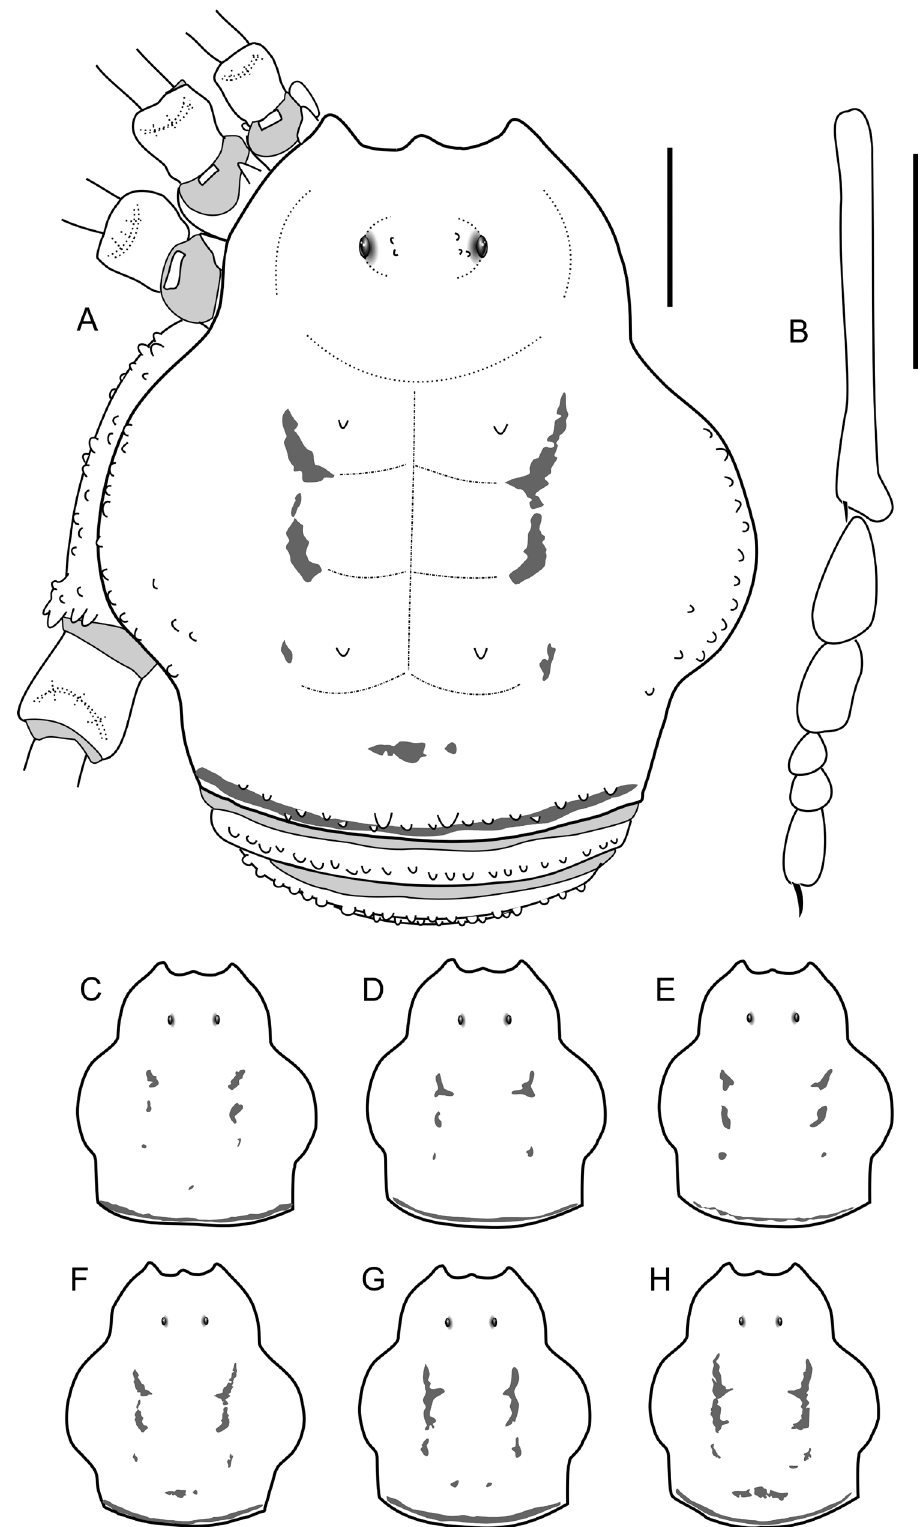
Fig. 28. Eulibitia scalaris (Sørensen in Henriksen, 1932) comb. nov. (MNRJ 17948). A . ♂, habitus, dorsal view. B . Left metatarsus and tarsomeres of leg I, prolateral view. C – F . Variation of spot pattern on dorsal scutum. C–E, G–H: ♀♀. F: ♂. Scale bars: 1